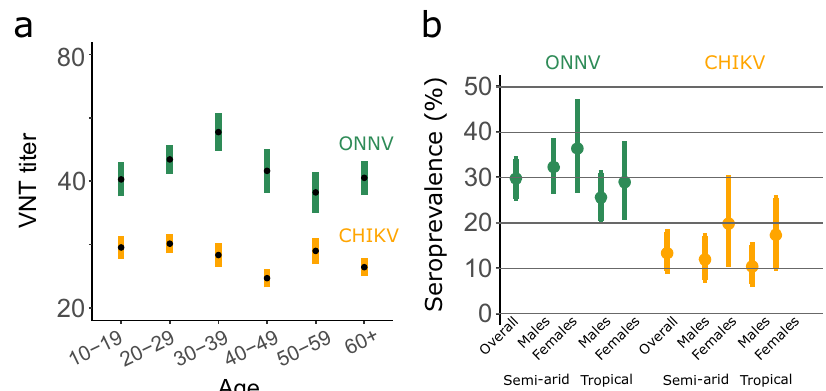
Fig. 3 Model estimates of ONNV and CHIKV seroprevalence in Mali. a Mean titer by age group (mean and standard error of the mean). Sample sizes for each age group are given in Supplementary Table 2. VNT: Virus neutralization titer. b Seroprevalence estimated with the model as a function of sex and living location. Dots represent the mean and error bars the 95% credible